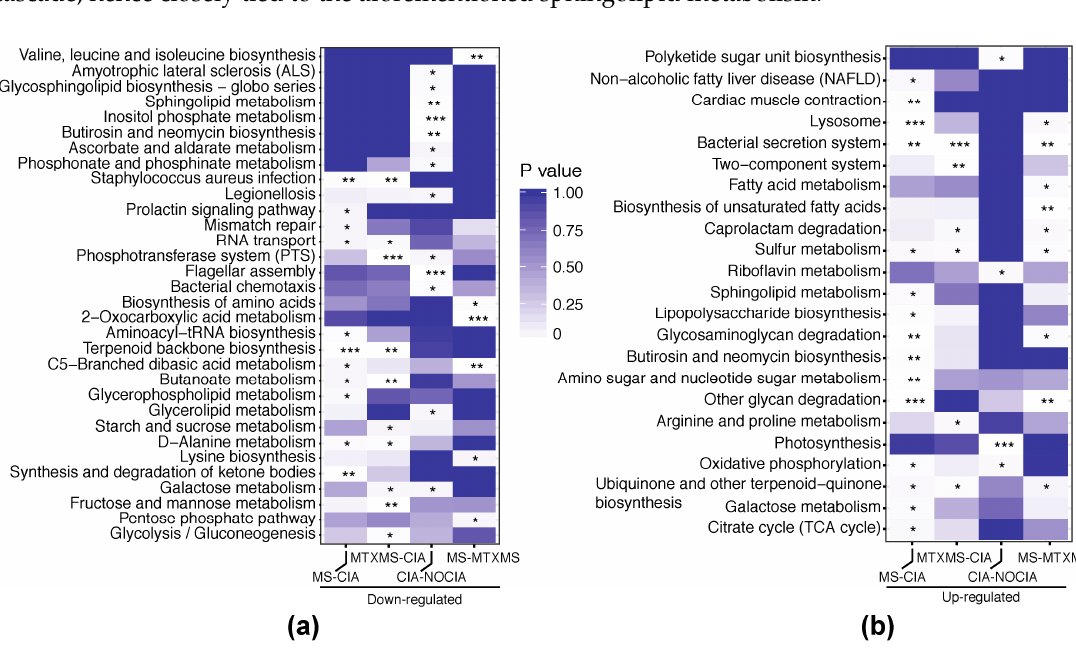
Figure 4. KEGG functional analysis of microbiome. In the rows the enriched functions and in the columns the conditions compared, labeled by increased (Up) or reduced (Down) abundance in each comparison. ( a ) KEGG pathways enriched by down-regulated microbiome KOs; ( b ) KEGG pathways enriched by upregulated microbiome KOs. Data are represented by modified Fisher’s exact p values, p ≤ 0.001 with ***, p ≤ 0.01 with **, p ≤ 0.05 with *. Table 1. KEGG pathways enriched by more and less abundant microbiome KEGG orthologies.